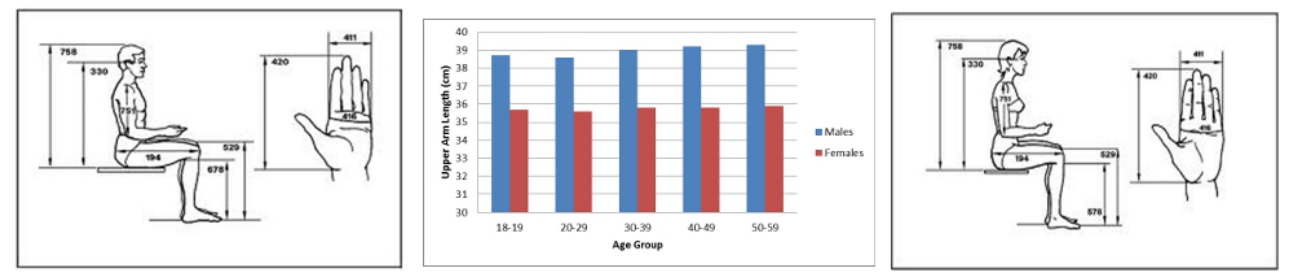
Figure 1. Illustration of the major anatomical measurements relevant to using a mouse from a seated position. Graph of gender differences in upper limb length (data taken from Anthropometric Reference Data for Children and Adults : Unites States, 2007-2010; U.S. Department of Health and Human Services)